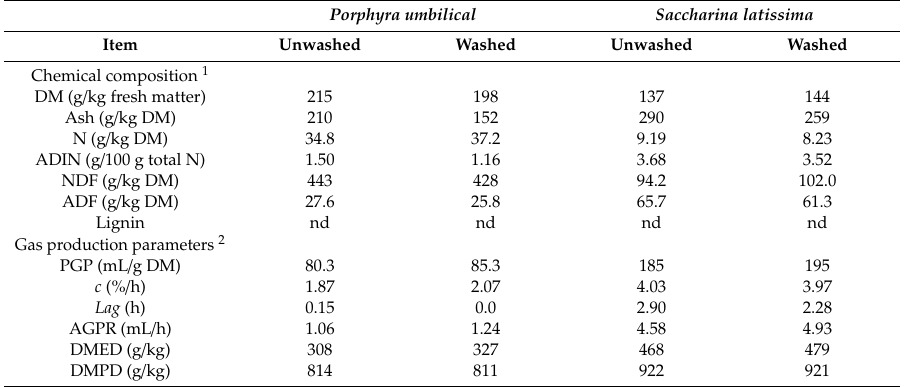
Table 1. Chemical composition and in vitro gas production parameters of samples of fresh Porphyra umbilicalis and Saccharina latissima